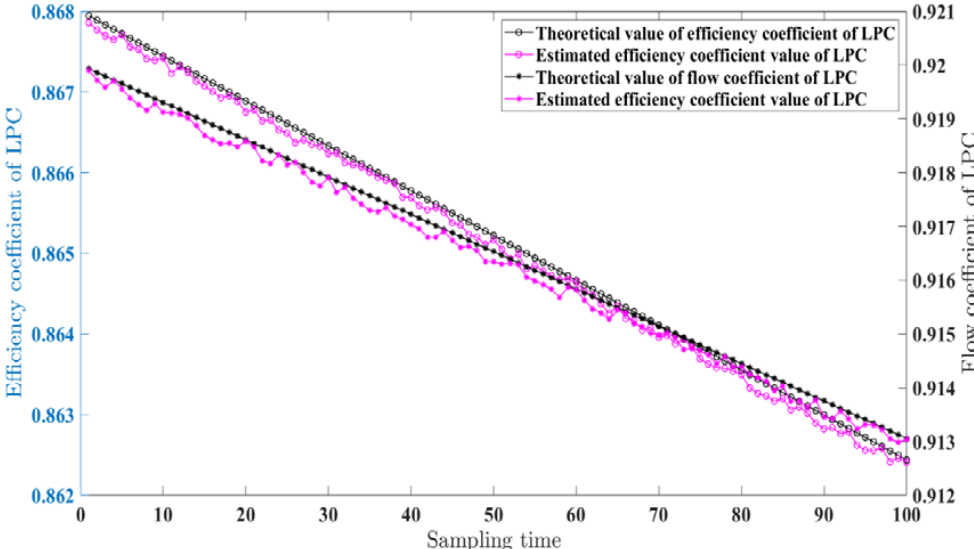
Figure 7. Estimated health parameters of low-pressure compressor (LPC) by the proposed hybrid filter. Table 2. Error analysis under the condition of slow degradation of performance based on proposed method.